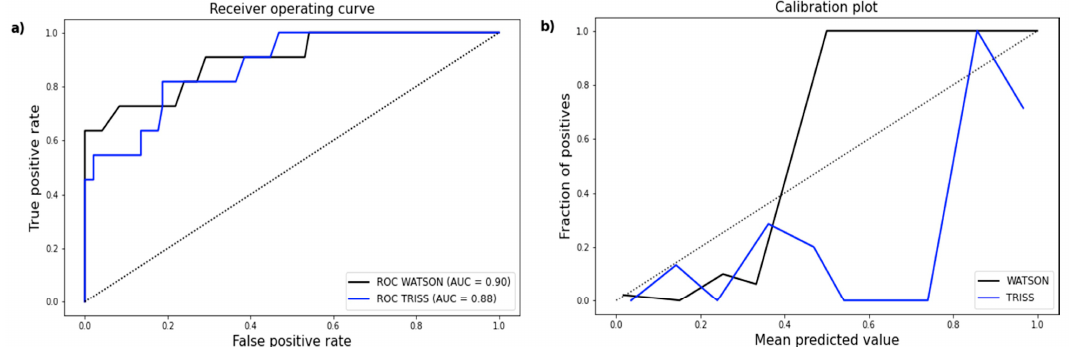
Figure 4. ( a ) ROC curve demonstrating an AUC of 0.90 (95% CI 0.79–99) for early death predicted by WATSON and an AUC of 0.88 (95% CI 0.77–0.97) for early death predicted by TRISS. ( b ) Calibration plot showing the distribution of observed early death and the corresponding prediction by WATSON and TRISS.